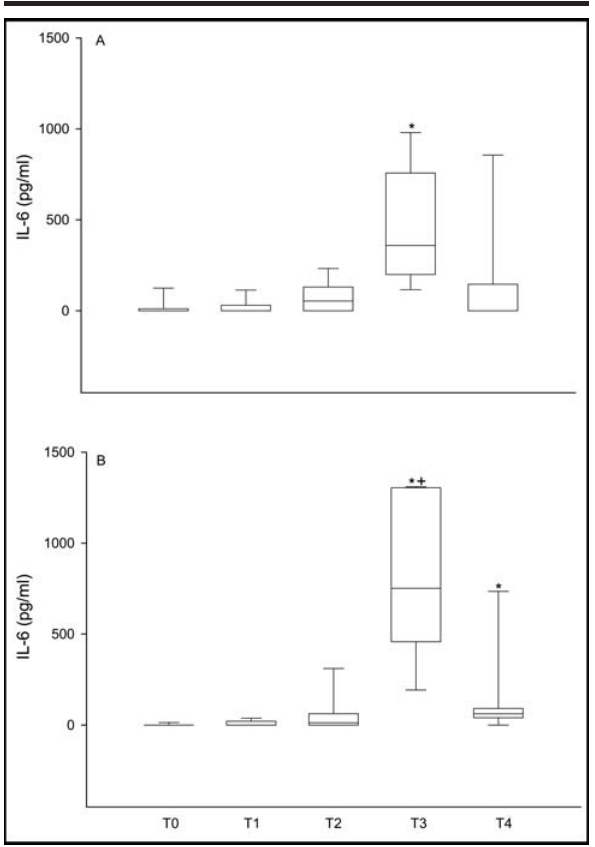
FIGURE 1 - Plasma IL-6 concentrations during and after bypass. Patients were submitted to bypass under normothermia with blood cardioplegia (n=10, panel A) or hypothermia with crystalloid cardioplegia (n=10, panel